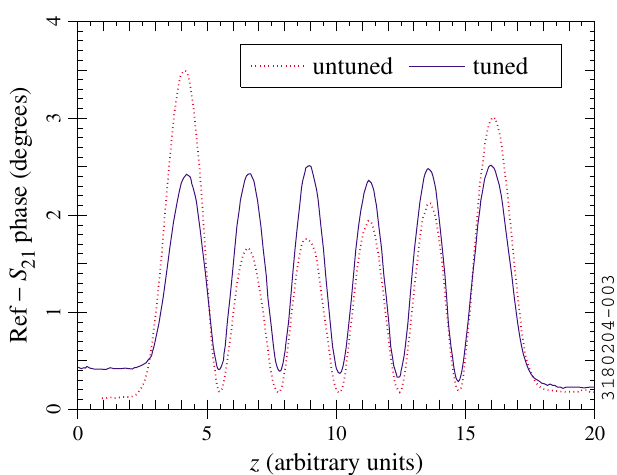
FIG. 5. (Color) (a) Drawing of the second and third 6-cell (cid:6) 0 : 47 Nb cavities and (b) photograph of the second cavity. The port for the input coupler can be seen on the left beam tube. Rings are welded around the outside of the irises to increase the mechanical stiffness of the structure. The end dishes for the attachment of the helium vessel are also visible.